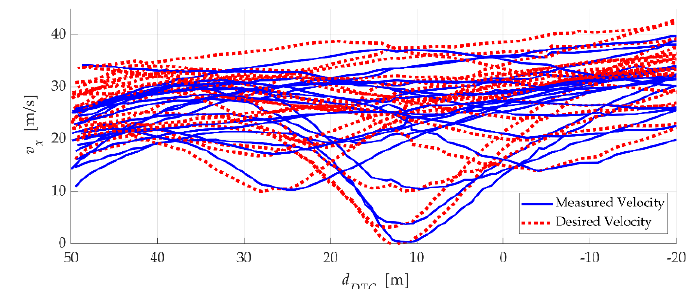
Figure 5. The measured and desired velocity profiles.